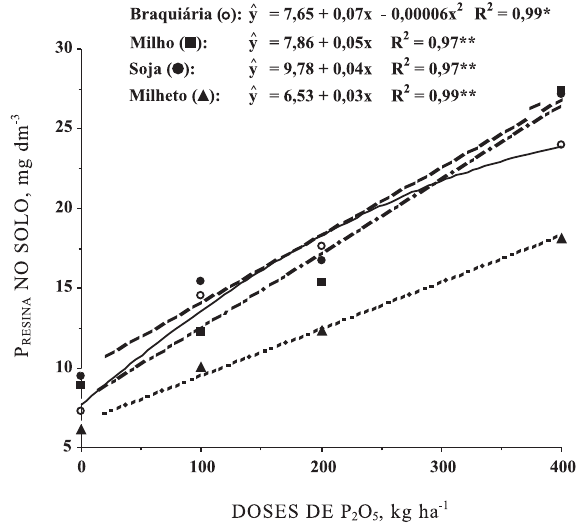
Figura 1. Teor de P no solo após o cultivo de resina milheto, braquiária, soja e milho aos 50 dias, em função da adubação com fosforita Alvorada. * e ** significativos a 5 e 1 %,